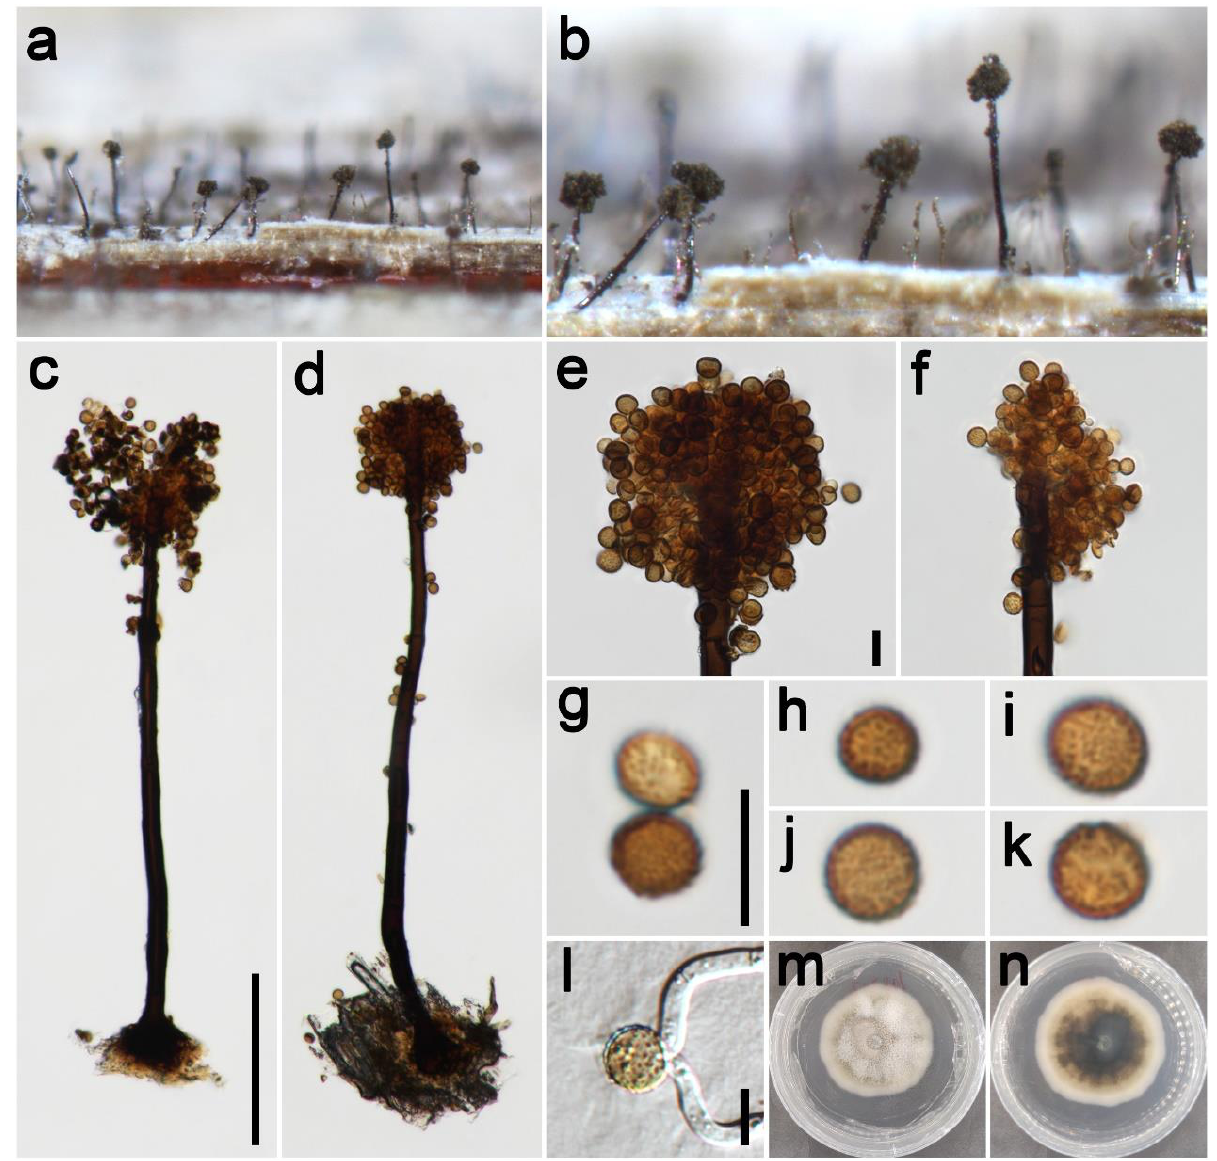
Figure 4. Periconia chimonanthi (HUEST 22.0134). ( a , b ) Colonies on the natural substrate; ( c , d ) conidiophores with spherical conidial heads; ( e , f ) conidial heads bearing conidiogenous cells and conidia; ( g – k ) conidia; ( l ) germinating conidium; ( m , n ) colony on PDA from above and below. Scale bars: ( c ) = 100 µ m, ( e , g , i ) = 10 µ m. Scale bar of ( c ) applies to ( d ). Scale bar of ( e ) applies to ( f ). Scale bar of ( g ) applies to ( h – k